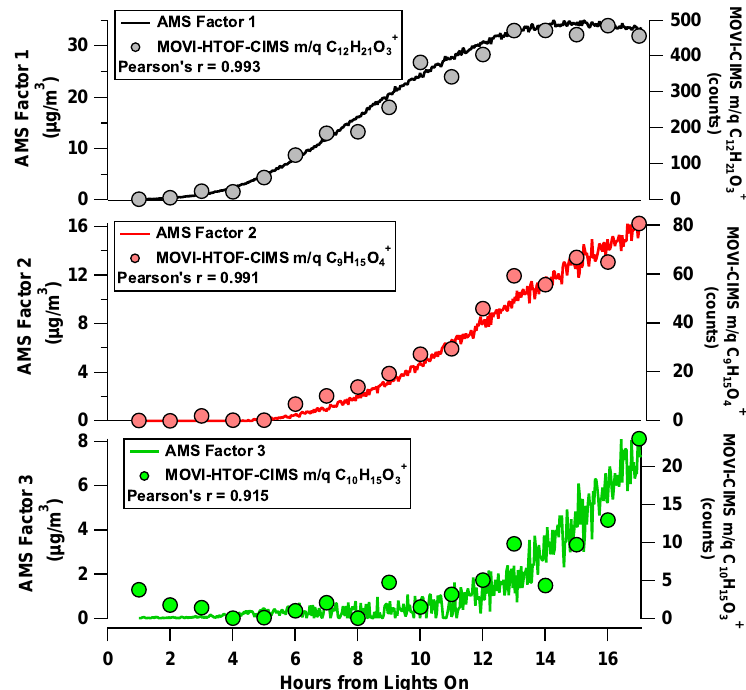
Fig. 11. Factor time series with MOVI-HRToF-CIMS heating-mode, aerosol-phase traces. Only the first 18h of data is available for the MOVI-HRToF-CIMS